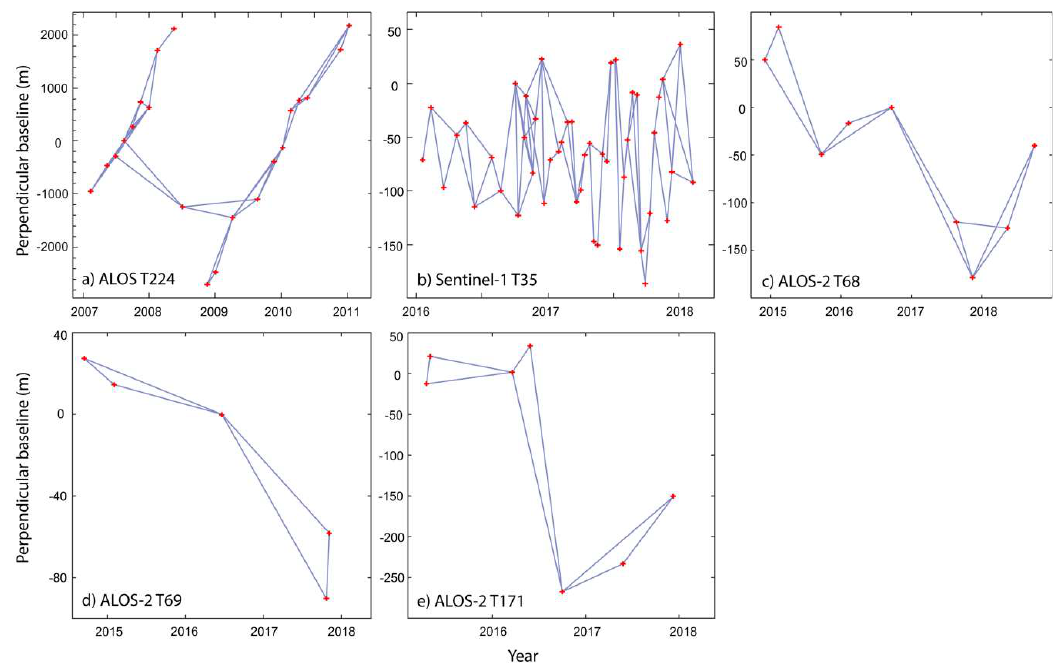
Figure 2. Spatial and temporal baselines of used interferometric synthetic aperture radar (InSAR) pairs from multiple tracks. ( a ) Advanced Land Observing Satellite (ALOS) track T224, ( b ) Sentinel-1A / B track T35, ( c ) ALOS-2 track T68, ( d ) ALOS-2 track T69, and ( e ) ALOS-2 track T171.